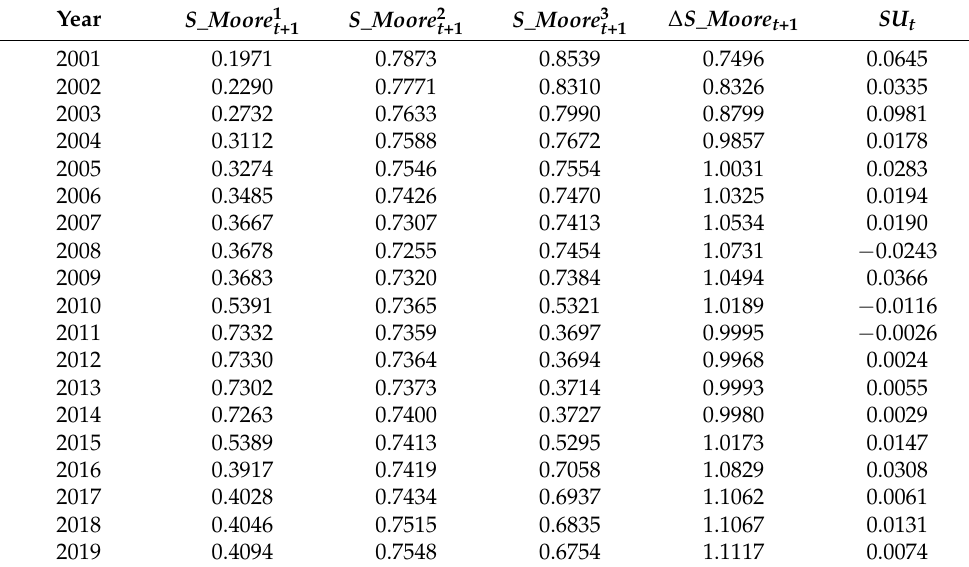
Table 2. Indicators of Changes in Fishery Industrial